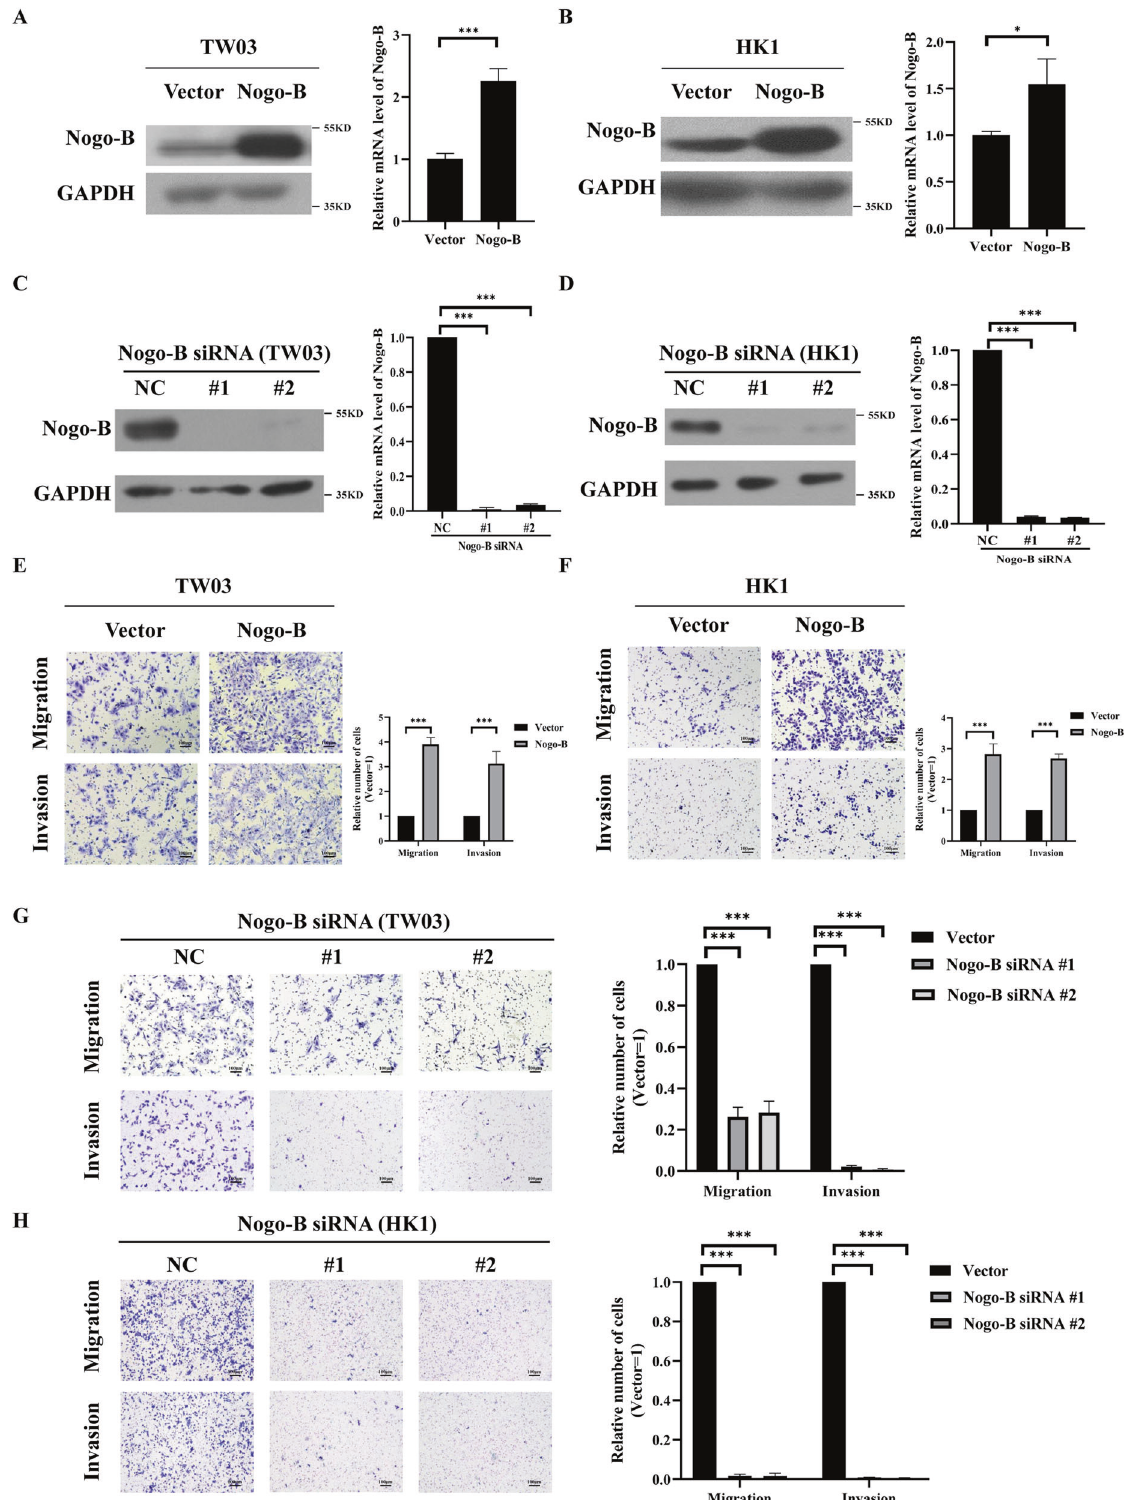
B + p-RhoA + ) and clinical characteristics in this group of NPC patients. 89 patients with Nogo-B + p-RhoA + were divided into two groups: one comprising patients with high expression of Nogo-B and p-RhoA (Nogo-B high p-RhoA high ) and the other comprising the